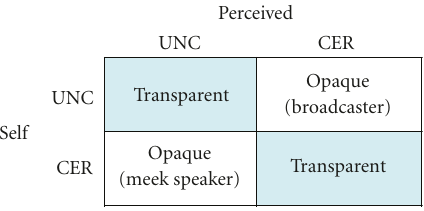
Figure 2: Self-awareness: we consider speakers to be self-aware if their internal level of certainty reflects the correctness of their utterance.